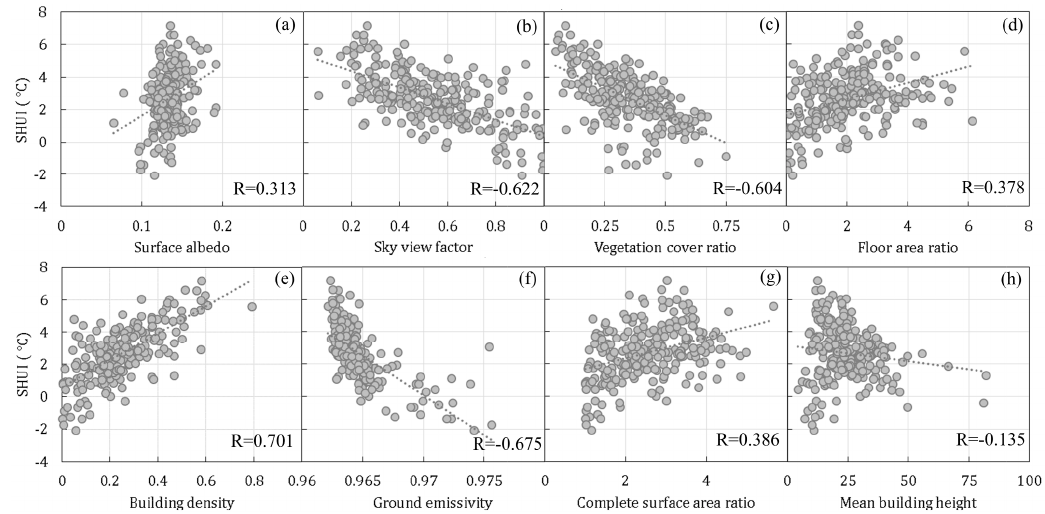
13 of 20 Figure 8. SUHI versus urban design factors of ( a ) surface albedo, ( b ) sky view factor, ( c ) vegetation cover ratio, ( d ) floor area ratio, ( e ) building density, ( f ) ground emissivity, and ( g ) complete surface